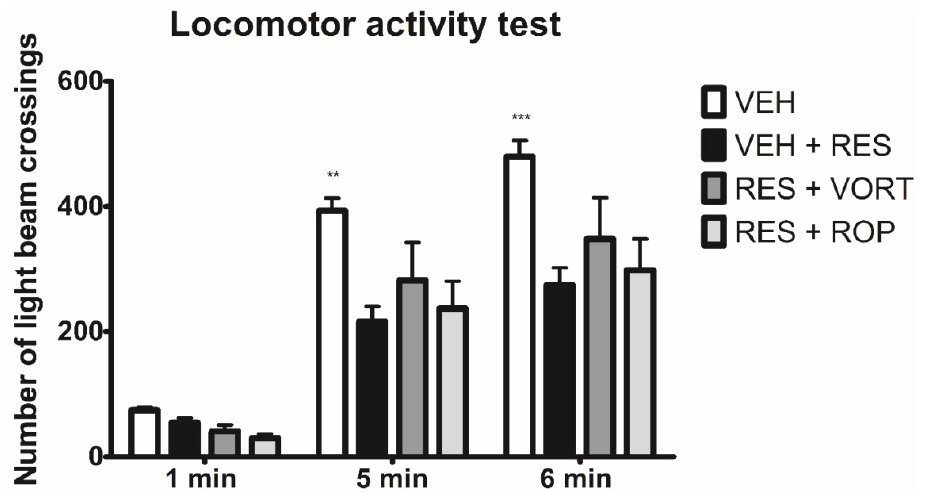
Figure 6. Effect of intraperitoneally administered vortioxetine (VORT; 10 mg/kg) and ropinirole (ROP; 10 mg/kg) on the locomotor activity of mice in the FM-like model induced by a 3-day administration of subcutaneous reserpine (RES; 0.25 mg/kg). The effect of test drugs on the number of light beam crossings was measured in the locomotor activity test carried out 1 h after drug administration. Results are shown as the mean number of light beam crossings ± SEM for n = 8. Statistical analysis: repeated-measures analysis of variance, followed by Tukey’s post hoc comparison. Significance vs. RES + VEH group at the respective time point of testing: ** p < 0.01 and *** p < 0.001.